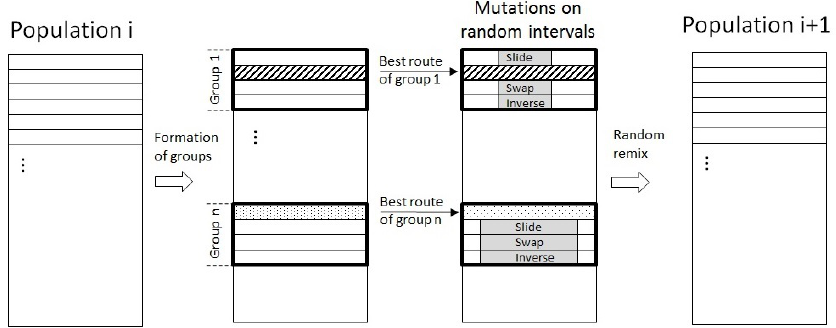
Figure 11. Principle of the genetic algorithm to generate a new population.